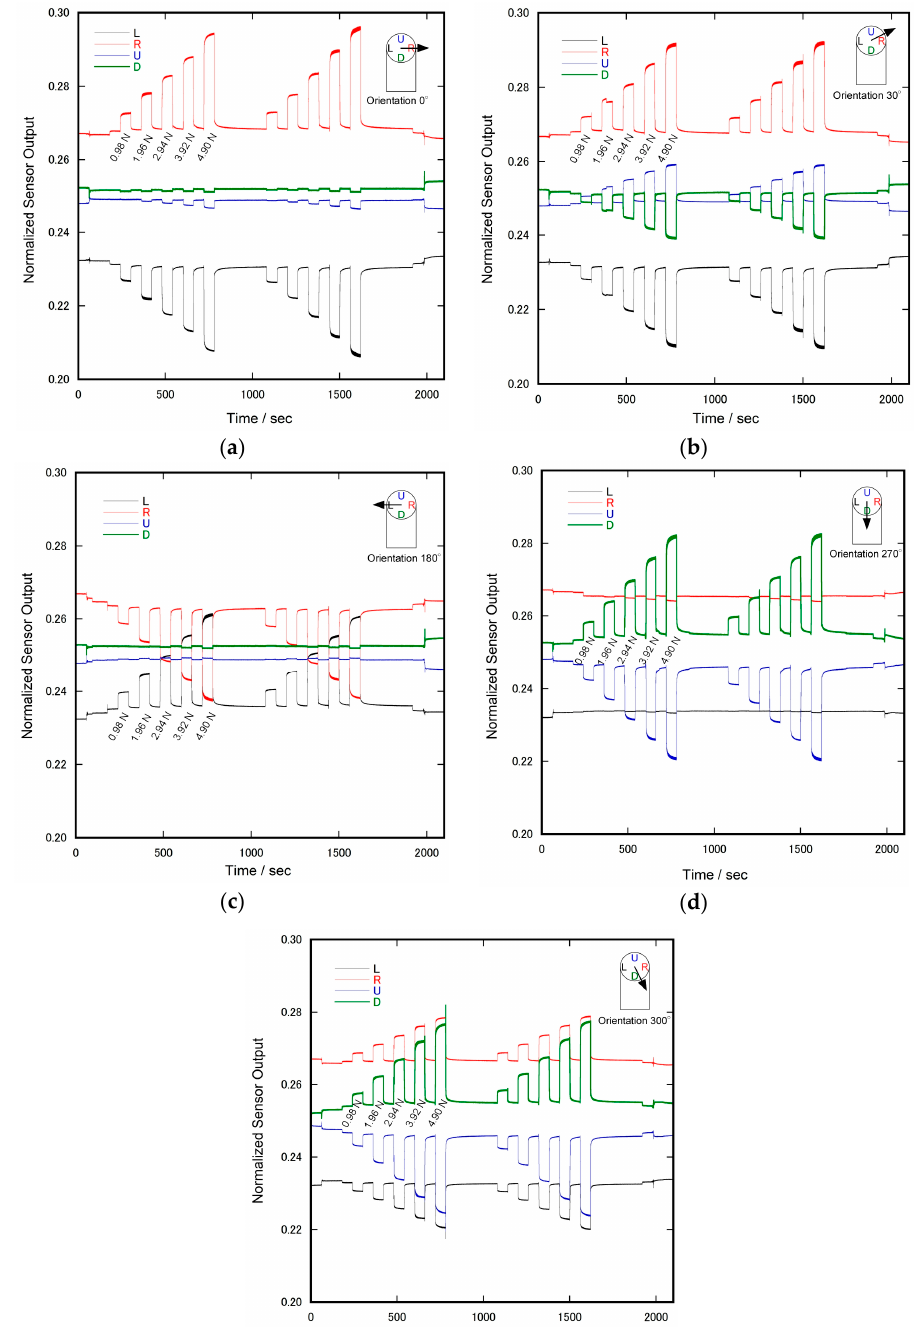
Figure 9. Time course of normalized sensor output during the application of shear force: The orientations of applied shear force were ( a ) 0; ( b ) 30; ( c ) 180; ( d ) 270; and ( e ) 300 degrees, respectively. The magnitude of the shear force was intermittently changed, and the same pattern of the application was repeated twice in each testing.